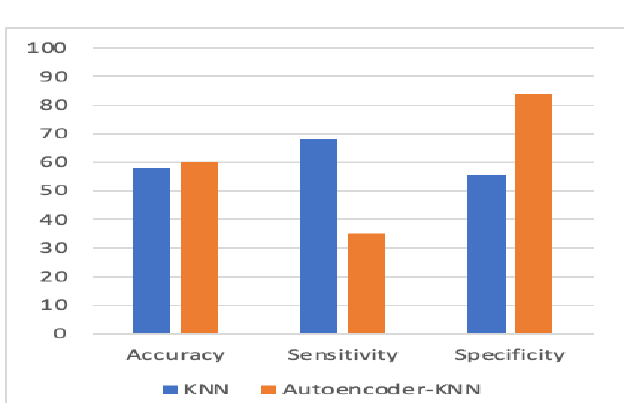
Figure 12. Autoencoder-RF vs. RF.